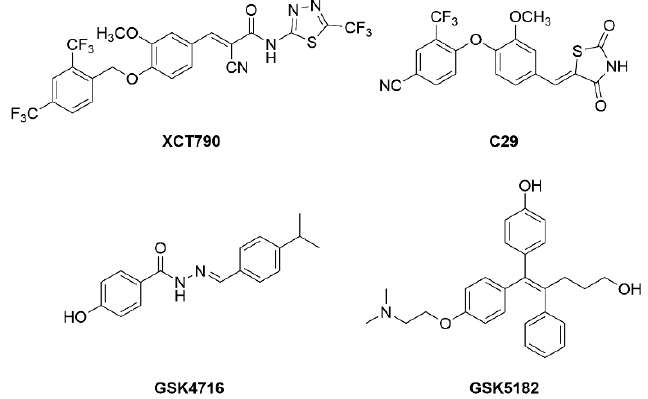
Figure 11. Chemical structures of known ERR modulators.